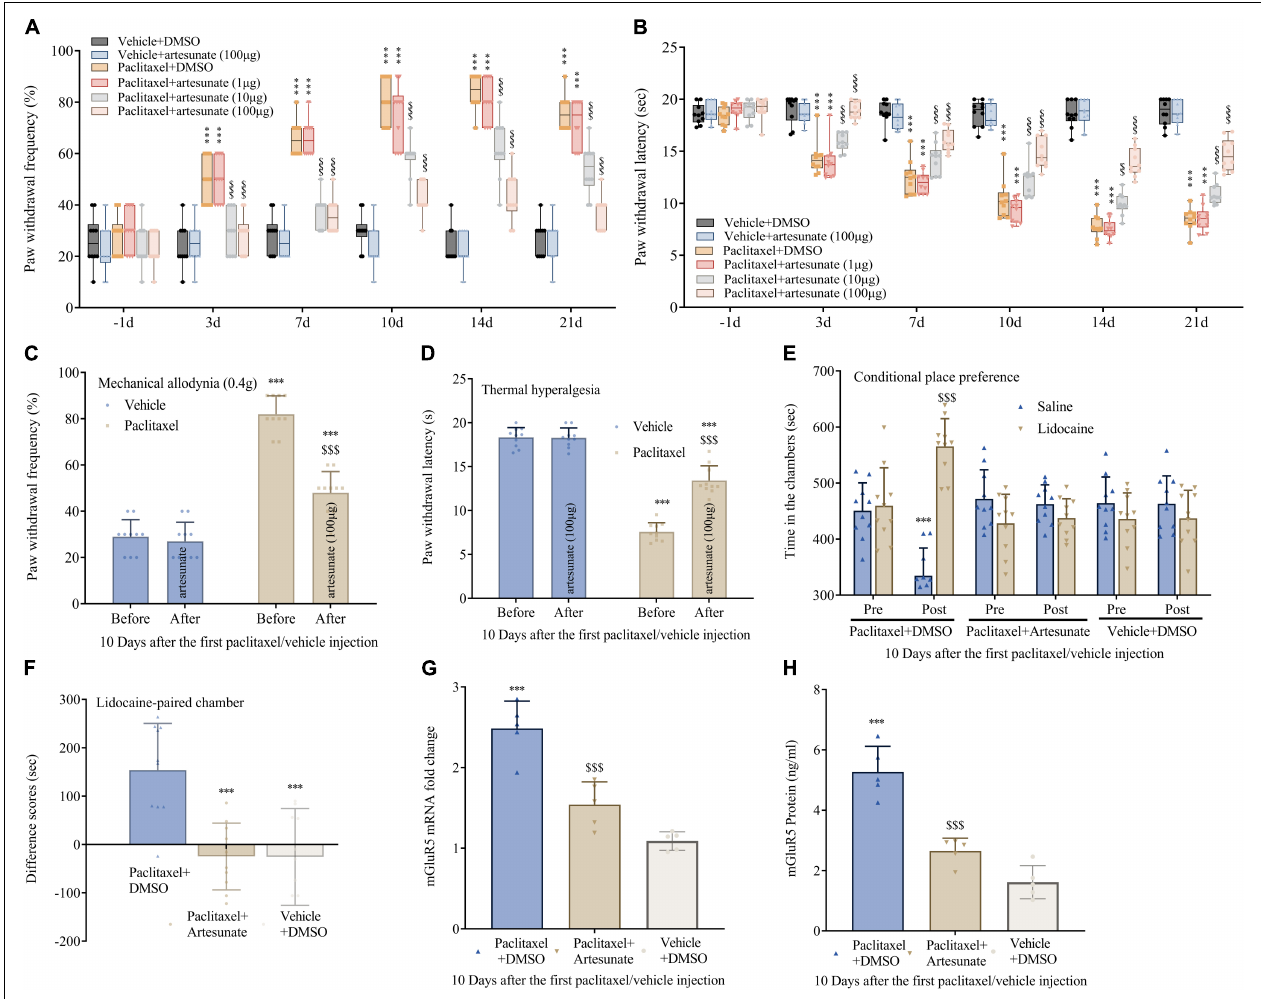
FIGURE 2 | Pre- and post-treatments with artesunate decrease paclitaxel-induced neuropathic pain and DRG mGluR5 expression in mice. Artesunate was administered by intrathecal injection 10 min prior to paclitaxel injection. (A,B) Artesunate treatment starkly and dose-dependently decreased paclitaxel-associated mechanical allodynia and thermal pain. (C,D) A single administration of artesunate attenuated paclitaxel-induced mechanical paw withdrawal frequency and thermal paw withdrawal latency 10 days following the initial paclitaxel administration. (E,F) Effects of artesunate on paclitaxel-associated spontaneous ongoing pain based on conditional place preference. (G,H) qRT-PCR and ELISA identified the DRG levels of mGluR5 after paclitaxel injection and artesunate treatment. Data are median with interquartile ranges, and individual data points are shown ( n = 10). (A,B) *** P < 0.001 vs. Vehicle + DMSO group; $$$ P < 0.001 vs. paclitaxel + DMSO group; (F–H) *** P < 0.001 vs. paclitaxel + DMSO